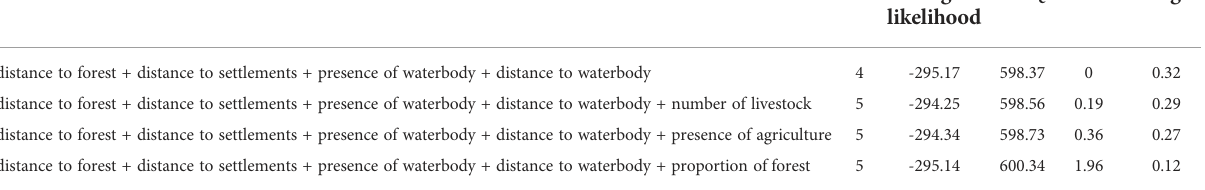
TABLE 2 Top models used for model averaging in this study.